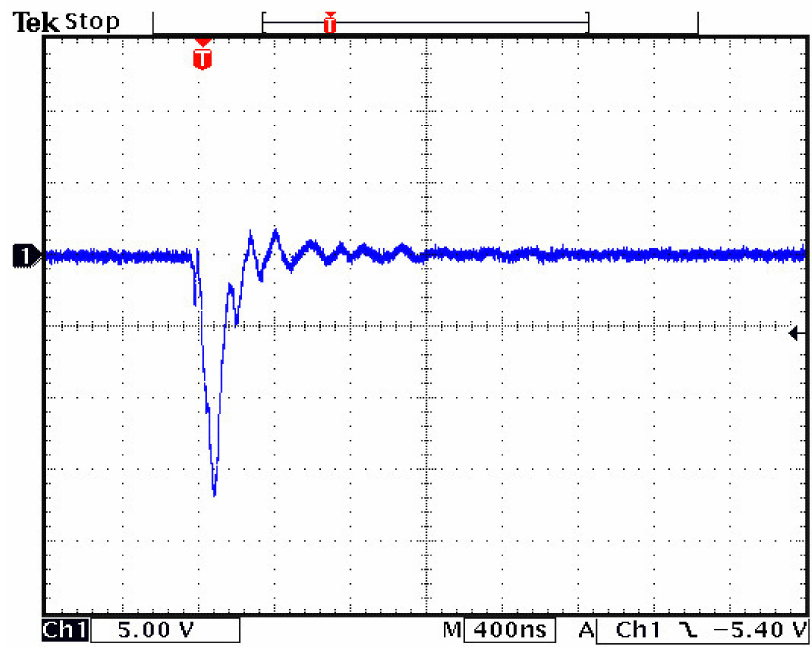
Figure 7. Characteristic oscillogram of discharge current between ATC and the ground (shunt 0.5 Ohm). T—trig moment, 1—channel